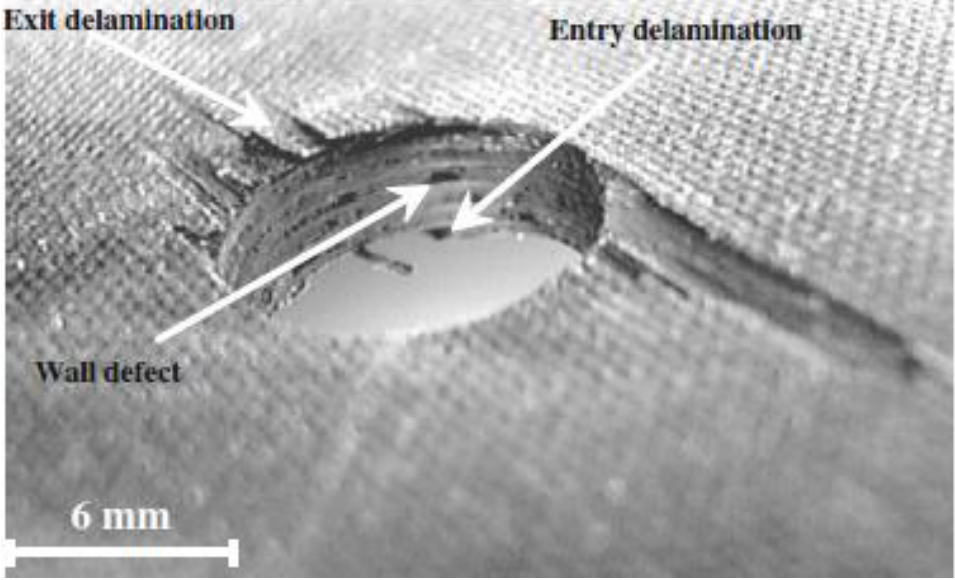
Figure 1. Drilling damages observed on CFRP laminate [1]. (Reprinted with permission from Ref. [1]. 2023, Springer Nature, https://www.springernature.com/gp).